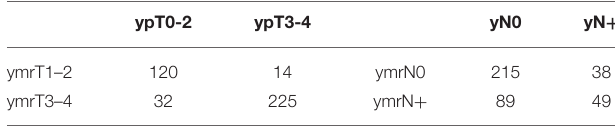
TABLE 2 | Confusion matrice for tumor restaging and node restaging.